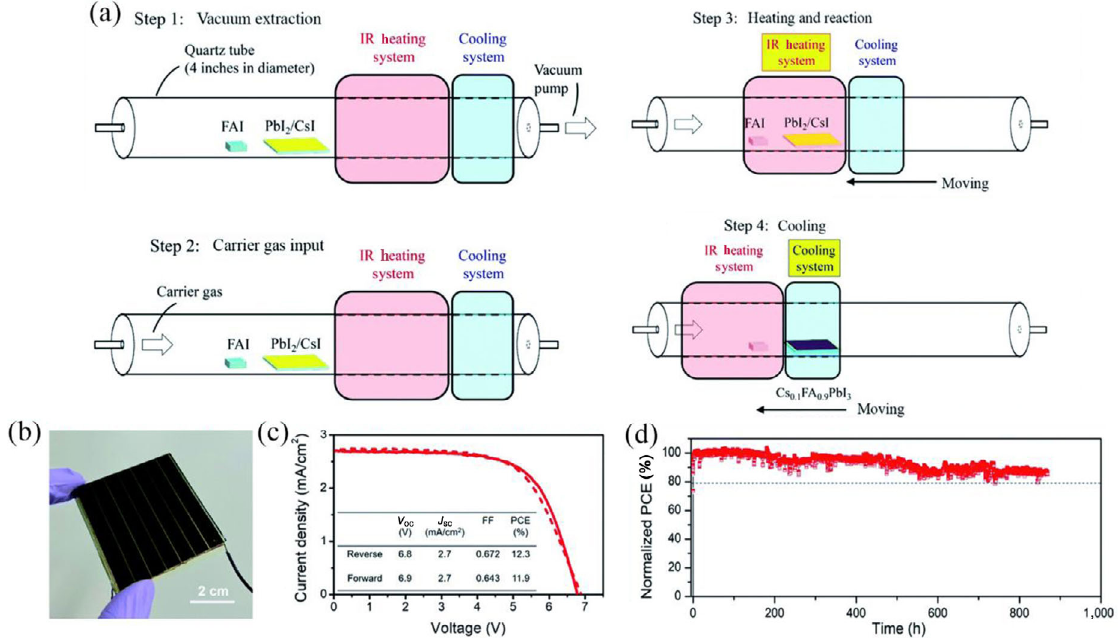
Figure 8 (a) Schematic illustrations showing the steps and major features for fabricating perovskite films via the RHCVD method. The cooling system is slid to the substrate position. (b) Photograph image of the 5 cm × 5 cm module. (c) I – V curve of forward and reverse scan from the optimized PPM with